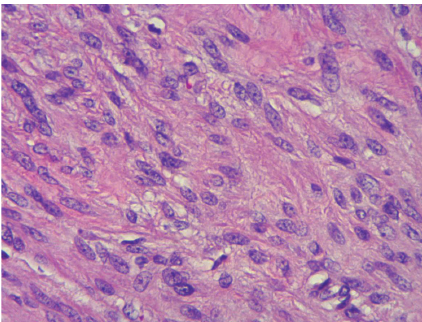
Figure 4: Hematoxylin-eosin staining of tumor section showing well-differentiated smooth muscle cells with eosinophilic cytoplasm and bland, blunt-ended nuclei (40x).